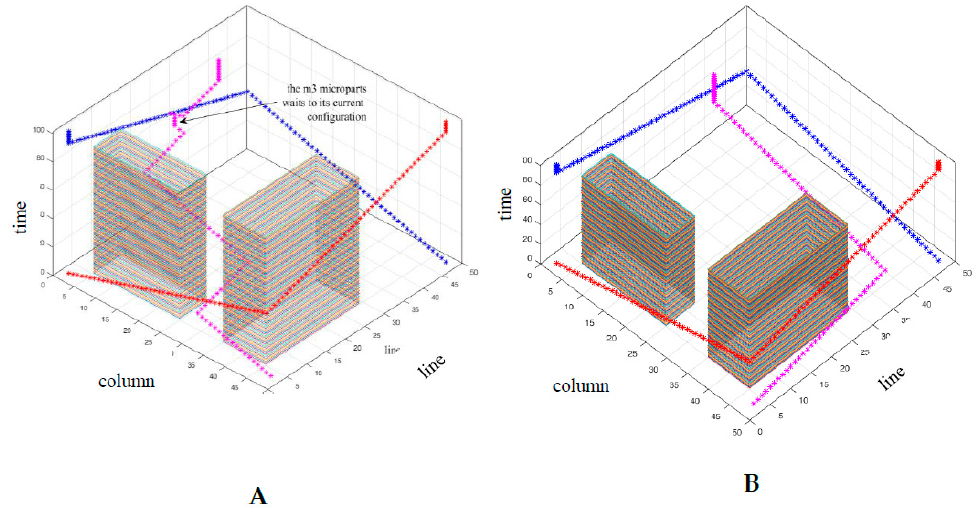
Figure 25. The path of the three microparts in T (time-space), ( A ) Equation (13) ( B ) Equation (12). Table 5. Start and goal configurations of the third micropart, comparing functions (11) and (12). Goal Configuration after Path Goal Configuration after Path Difference of Time Steps Micropart Computation with (13) Computation with (12)